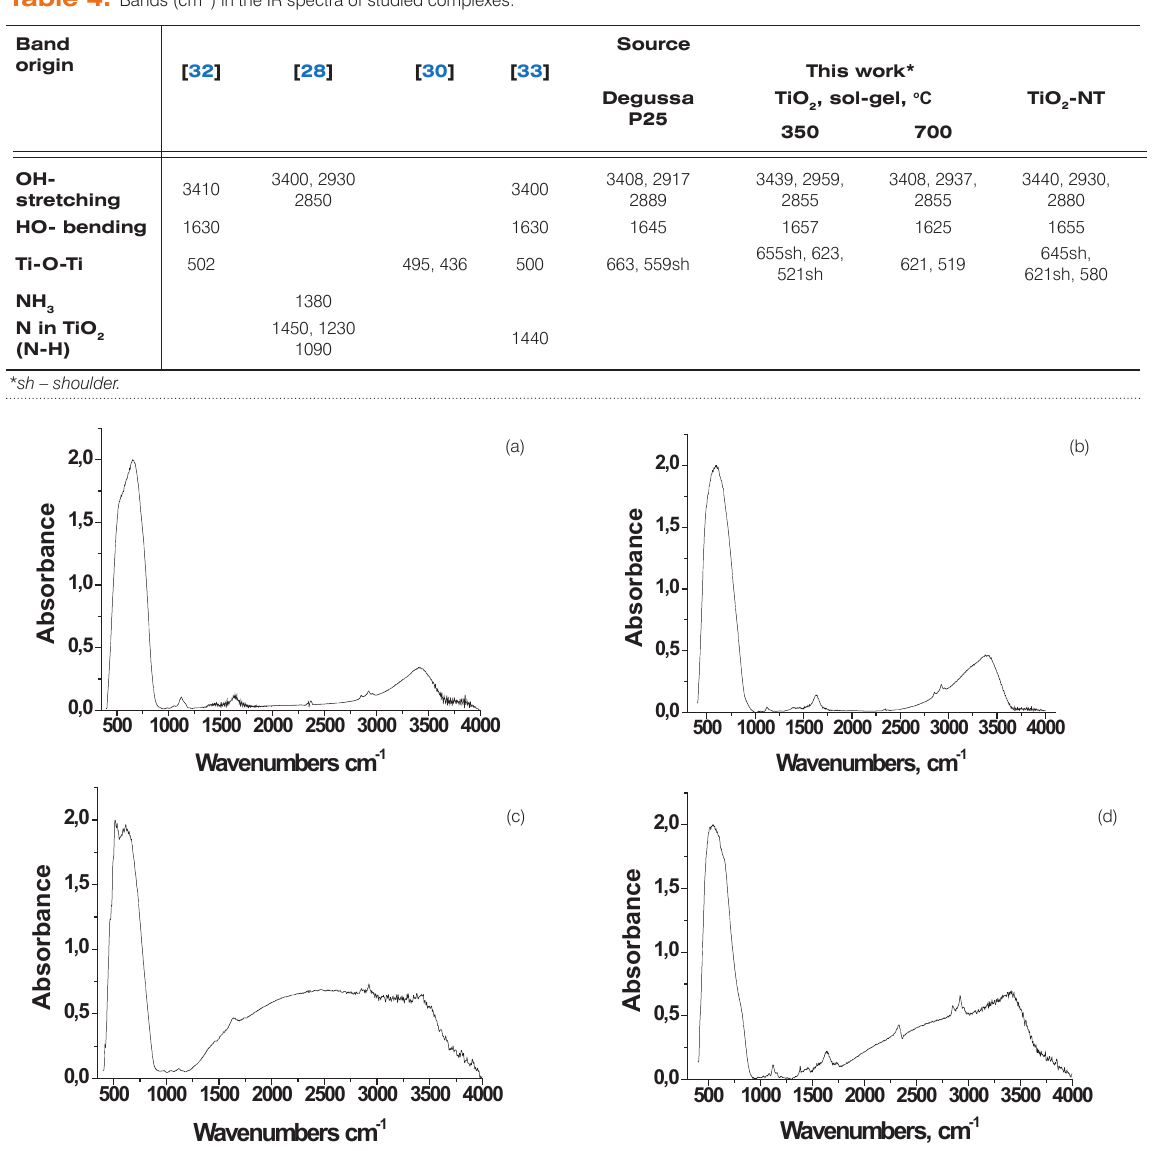
Figure 10. IR spectra of Degussa TiO